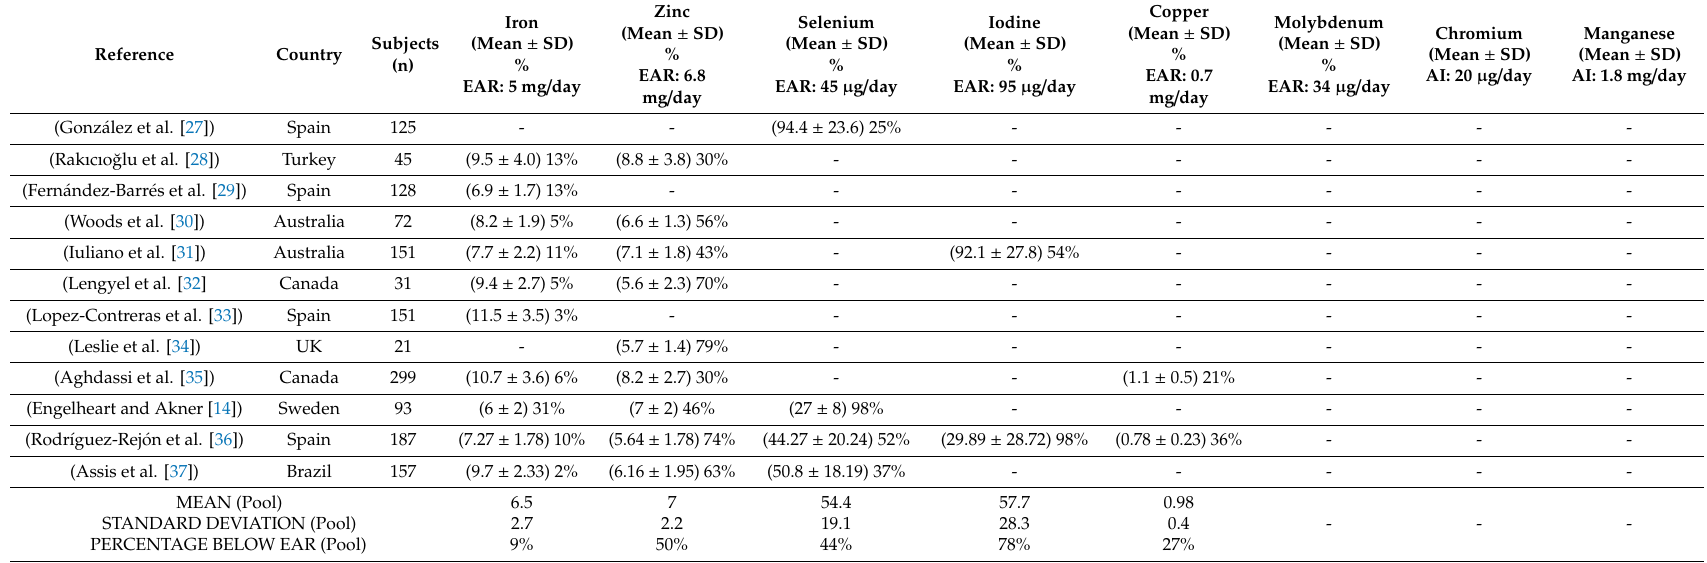
Table 6. Individual study data and percentage of institutionalised older adults at risk of inadequacy for trace minerals in